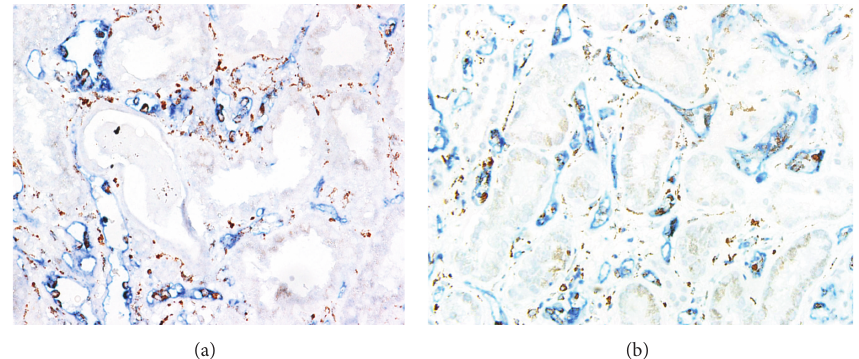
Figure 5: Capillary variation between antibody-mediated rejection (ABMR) and transplant glomerulopathy (TG). CD31 and CD68 (labeled in brown) costaining showed peritubular capillary (PTC) dilation was much more severe in the TG group (a) than in the ABMR group (b).